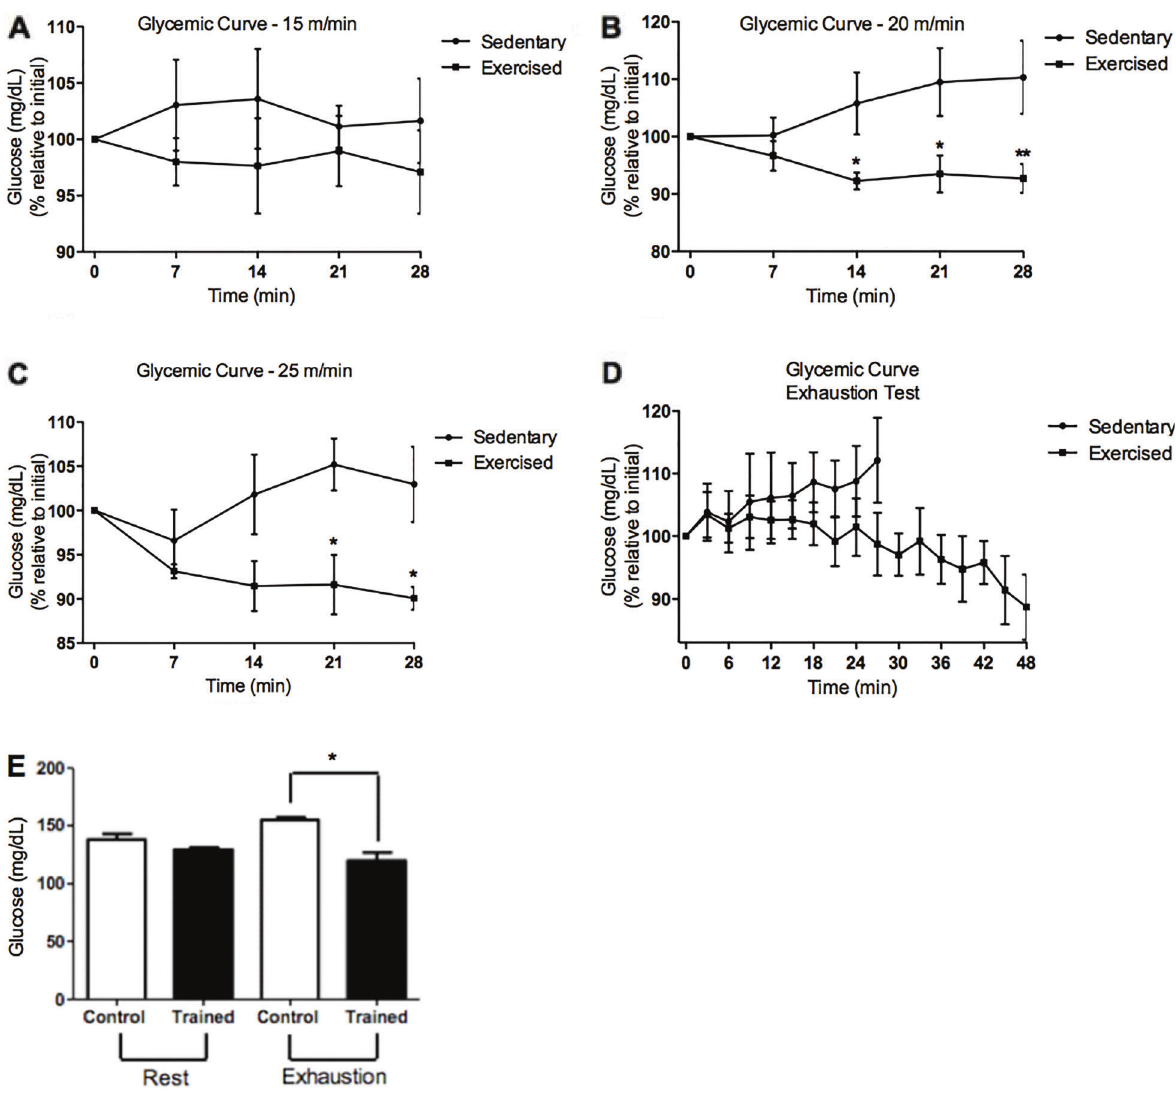
Figure 1. Effects of endurance training on blood glucose during constant ( A, B and C ) and incremental speed test. During the incremental speed test, the sedentary group achieved exhaustion at the 27th min, while the exercised group was exhausted only at the 48th min ( D ) with lower blood glucose levels ( E ). Data are reported as means ± SE of 6 animals per group. *P o 0.05, **P o 0.01, one- way ANOVA followed by the Tukey ’ s multiple comparison post hoc test was used to assess differences among groups and Student ’ s t -test for comparison between two